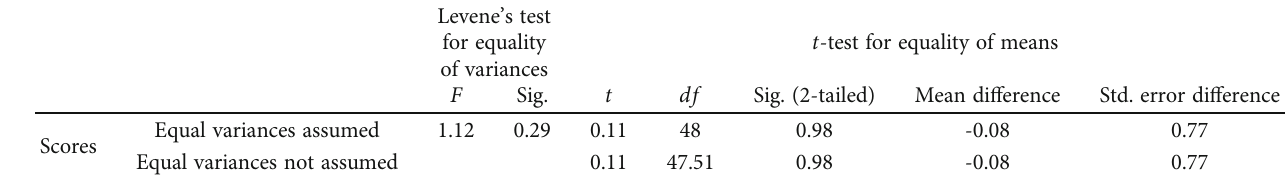
Table 2: Independent sample t -test (pretest of both groups).